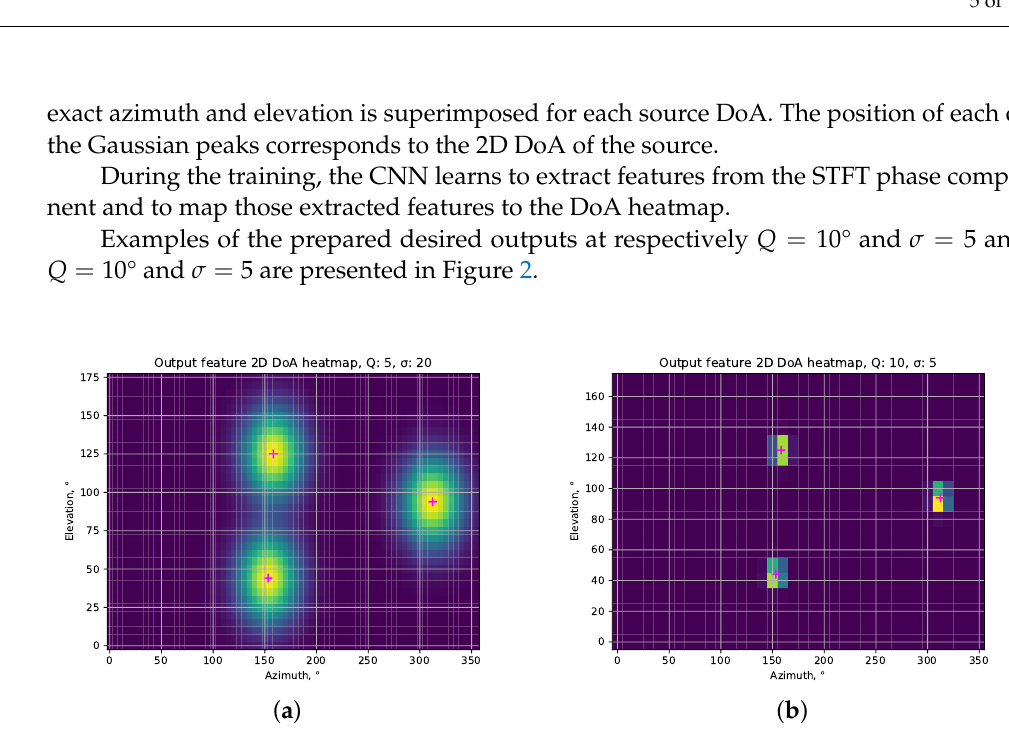
Figure 2. Examples of 2D DoA heatmap (( a ) with parameters Q = 10°, σ = 5; ( b ) with parameters Q = 10°, σ = 5; ground truth DoAs are marked with magenta